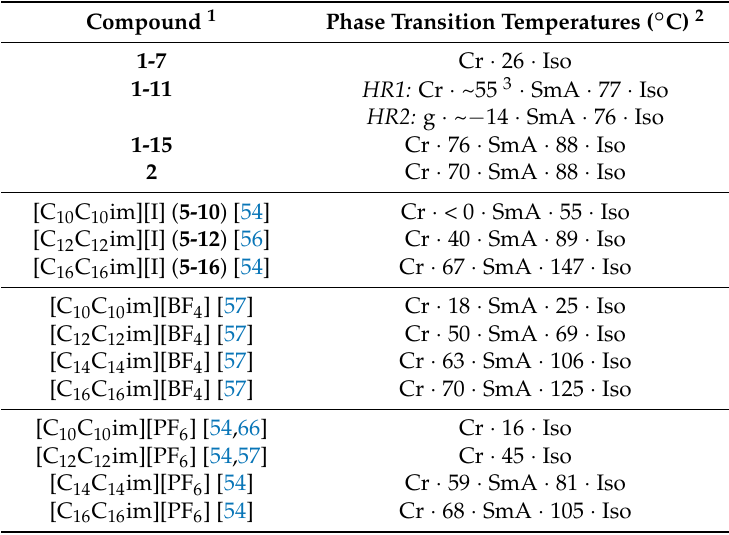
Table 3. A comparison of the thermal phase characteristics exhibited by 1,3-bis( n -alkyl)substituted imidazolium salts and the 4,5-bis( n -alkyl)imidazolium salts 1-11 , 1-15 , and 2